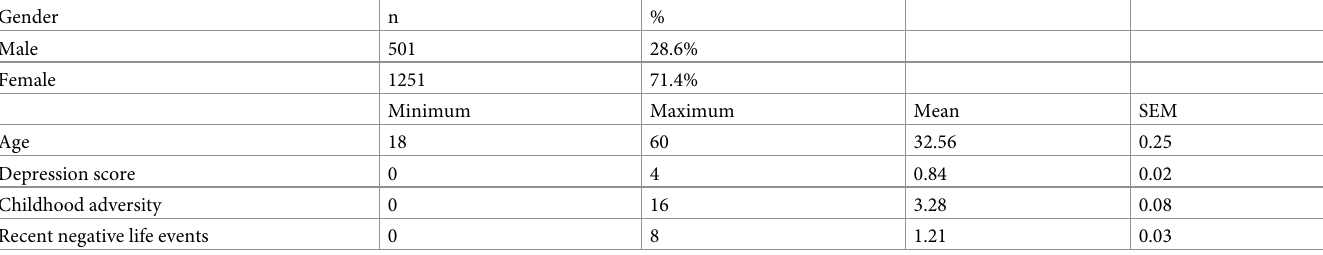
Table 1. Descriptive statistics of the study